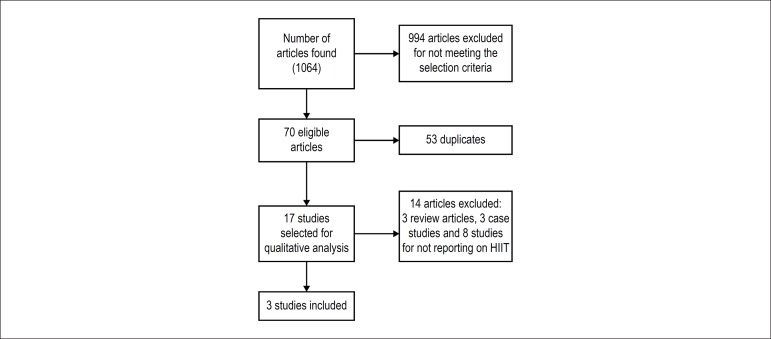
Flowchart of the search and selection process of the articles included in
this review.